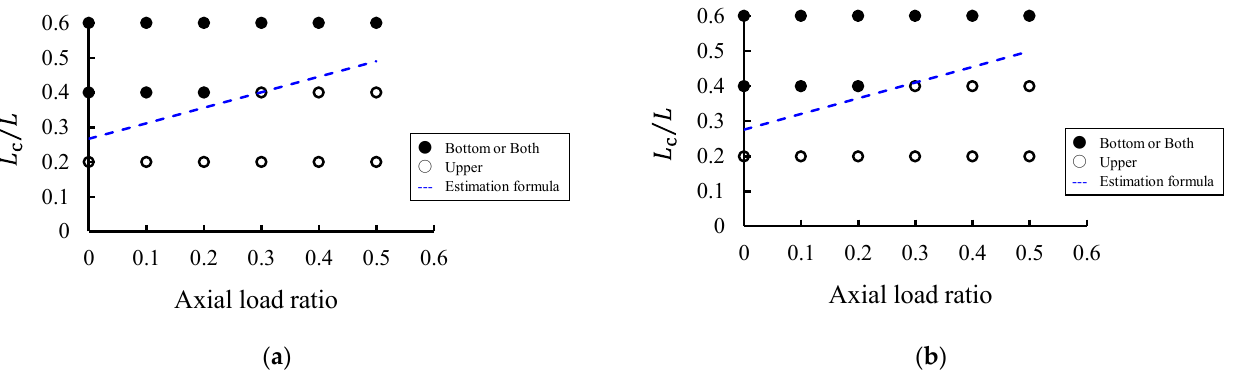
Figure 13. Buckling position relationships with 𝑛 and 𝐿 (cid:2913) /𝐿 : ( a ) Model C-009-020; ( b ) Model C-009- 040.